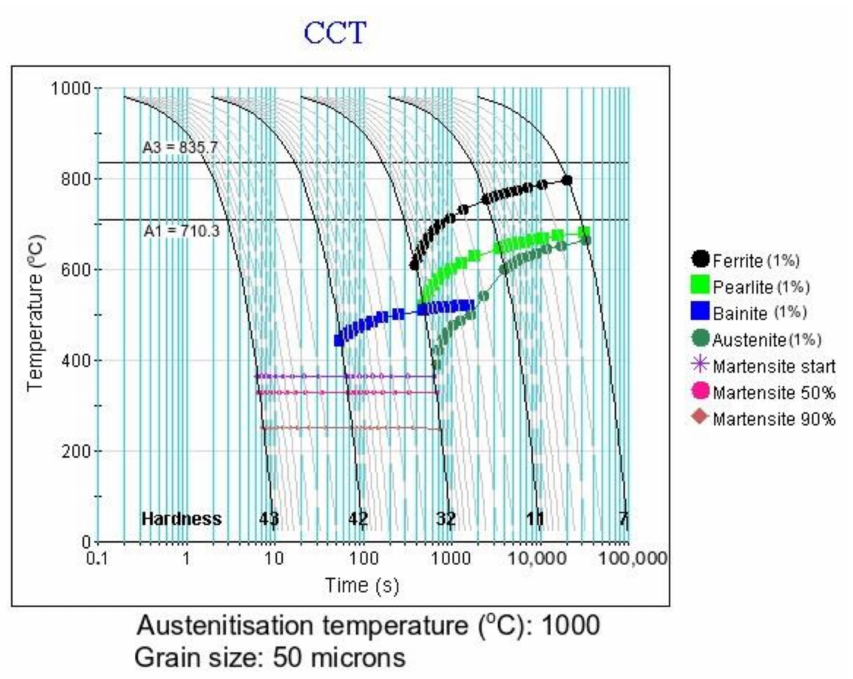
Figure 2. The calculated continuous-cooling-transformation (CCT) diagram of analyzed steel, to- gether with estimated hardness